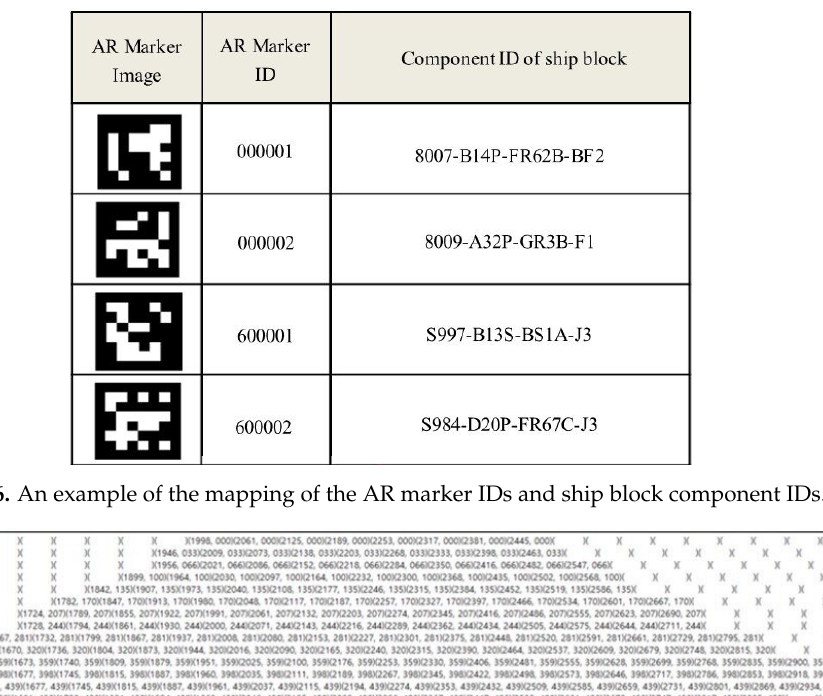
Figure 5. QR code, AR maker, AR markers on the ship block and dual AR maker printed on steel plate.